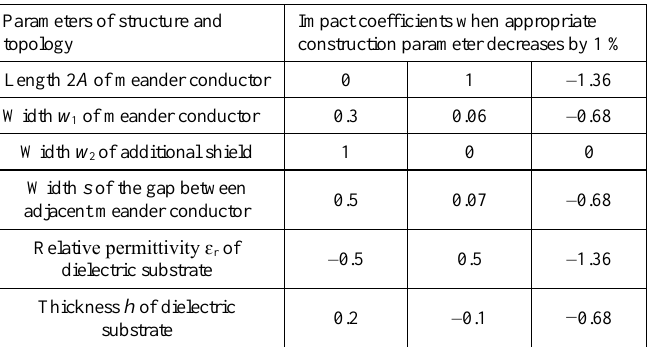
I NFLUENCE OF THE C ONSTRUCTIVE P ARAMETERS OF M EANDER S LOW -W AVE S YSTEM W ITH A DDITIONAL S HIELDS G ROUNDED AT B OTH E DGES ON ITS E LECTRICAL P